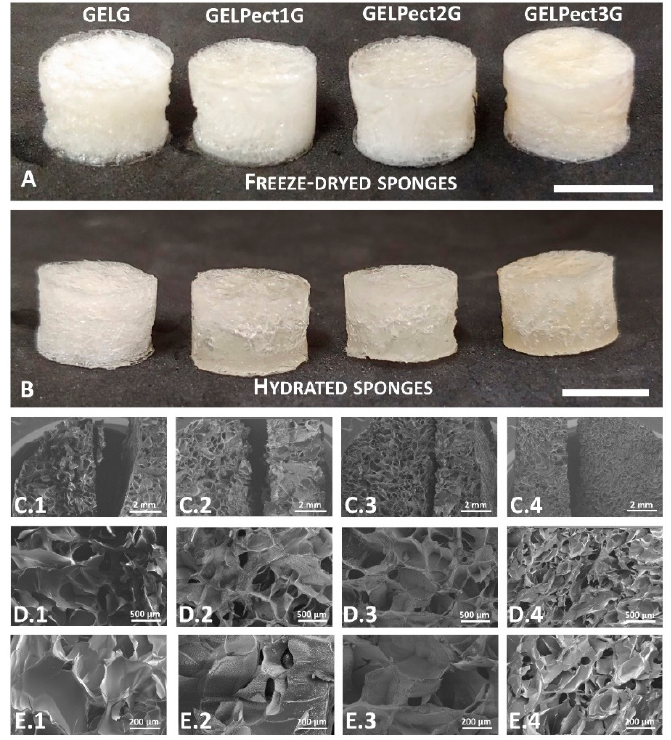
Figure 2. Images of GELG, GELPect1G, GELPect2G, and GELPect3G sponges as-freeze dried ( A ) and after rehydration ( B ); SEM images of freeze-dried GEL ( C.1 , D.1 , E.1 ), GELPect1G ( C.2 , D.2 , E.2 ), GELPect2G ( C.3 , D.3 , E.3 ), and GELPect3G ( C.4 , D.4 , E.4 ) sponges (scale bars: A, B = 10 mm, C.1–C.4 = 2 mm, D.1–D.4 = 500 µm, E.1–E.4 = 200 µm).